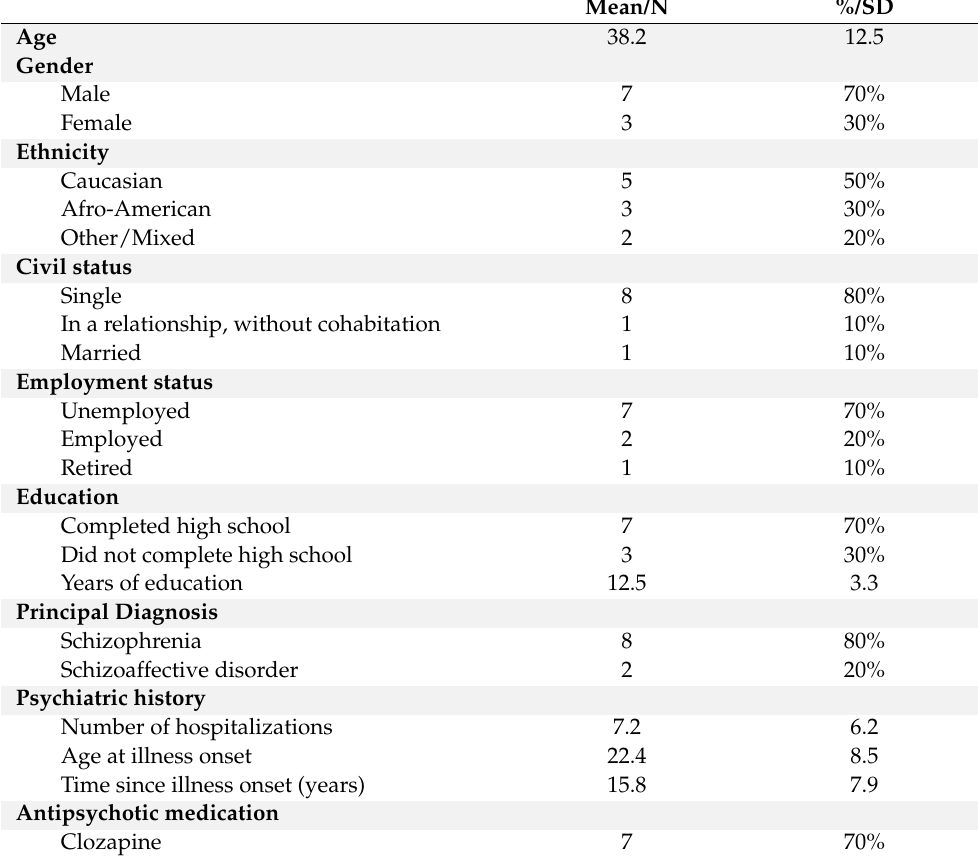
Table 1. Baseline characteristics. N =